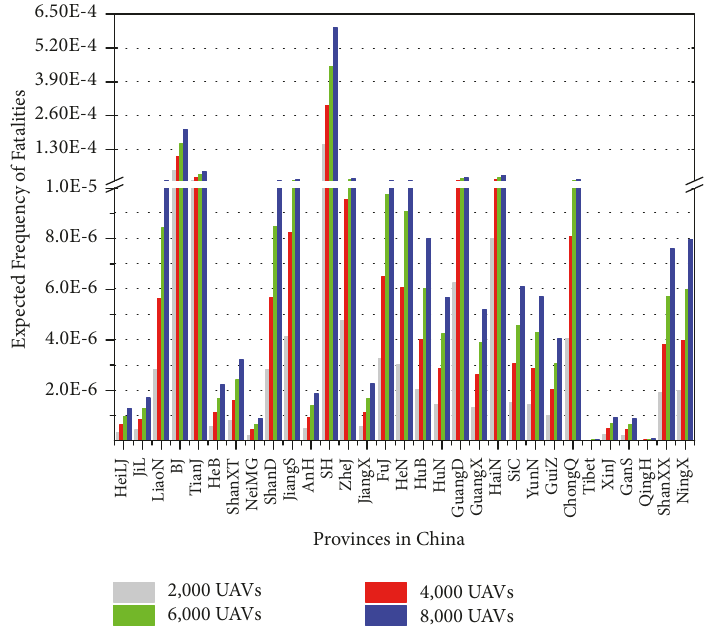
Figure 9: Expected frequency of fatalities in China.